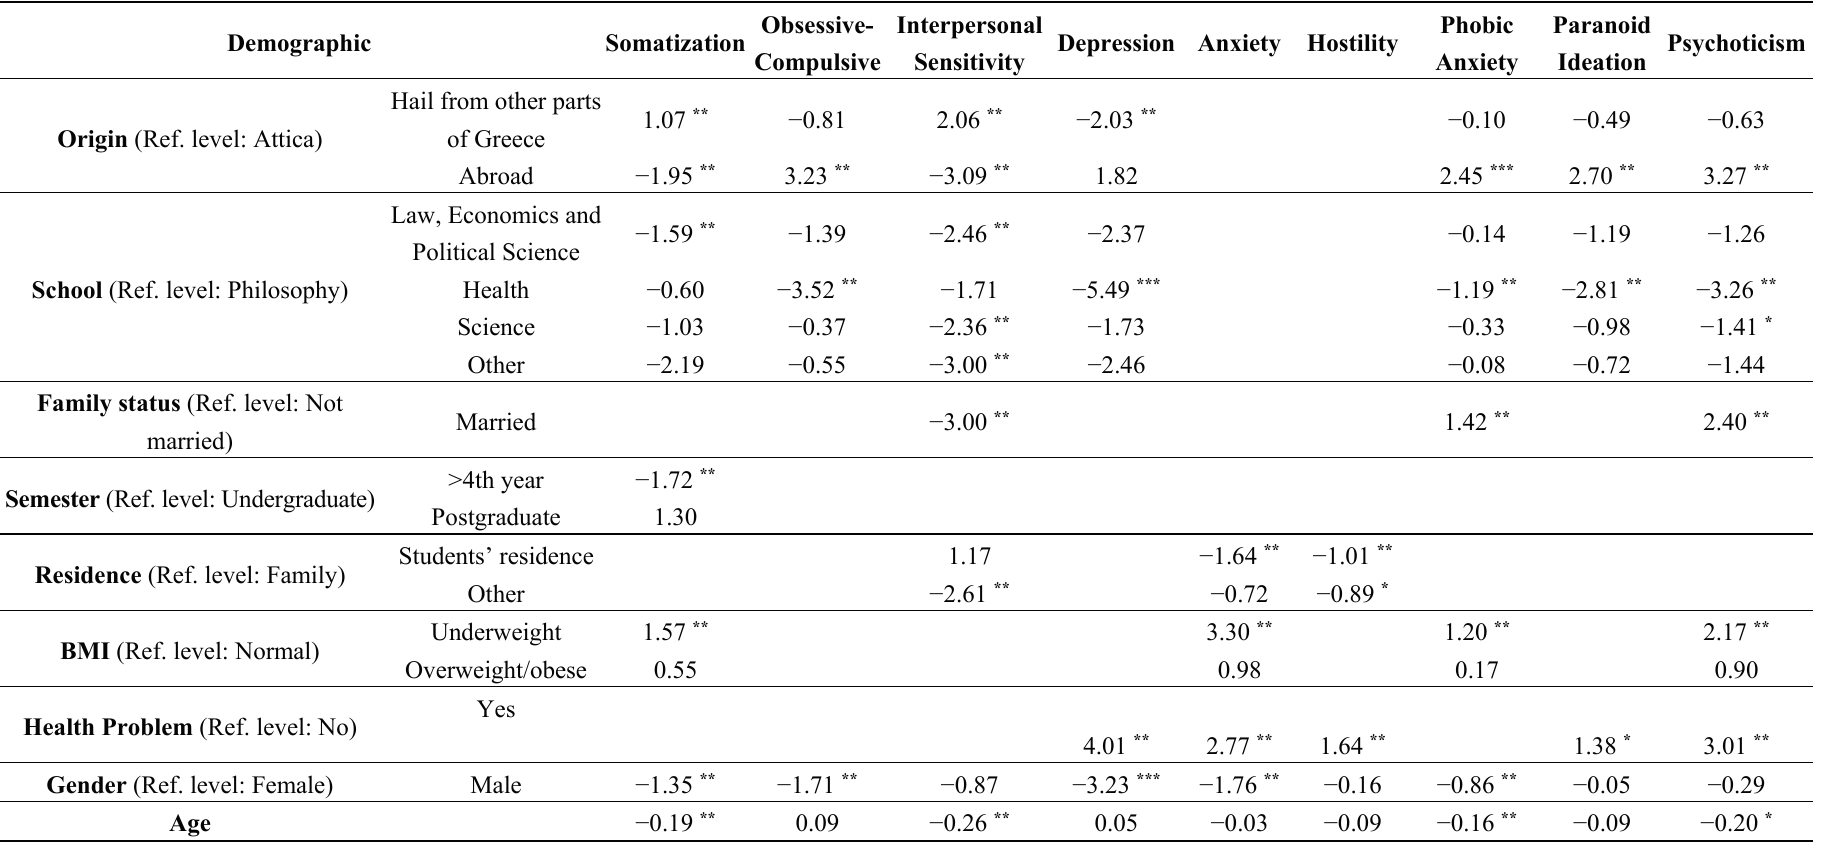
Table 8. Robust linear regression model for each scale of SCL-90.